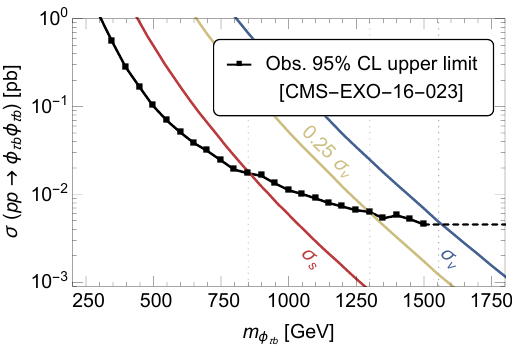
Figure 15 . Bounds on scalar and vector MLQs which decay into ( (cid:28)b )( (cid:28)b ) (cid:12)nal states. The observed 95% CL upper limit on the production cross section times branching fraction (black solid line) is taken from searches for LQs in this (cid:12)nal state at CMS [59] that stopped at 1.5 TeV. The remainder of the analysis is analogous to (cid:12)gure 8.